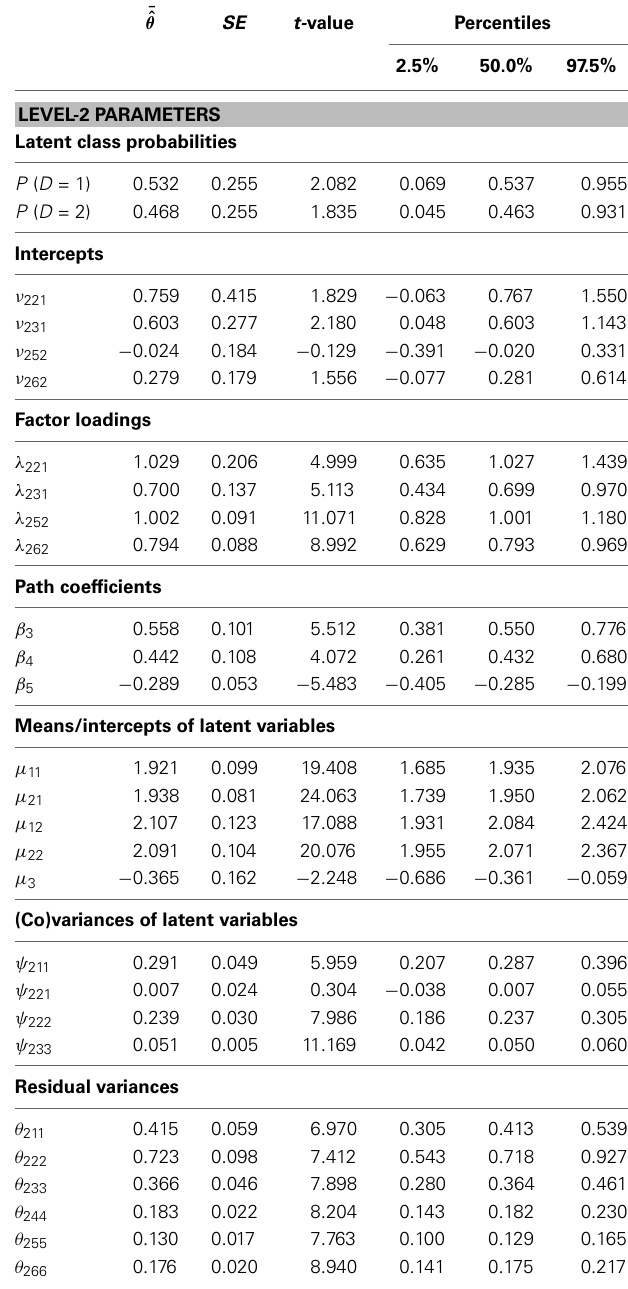
Table 1 | Mean parameter estimates, standard errors, t -values, and 2.5, 50.0, and 97.5%